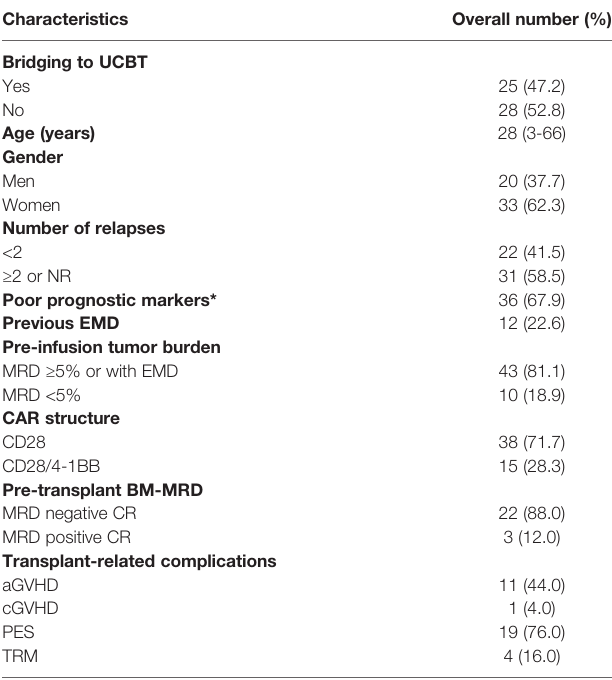
TABLE 1 | Characteristics of the 53 patients.